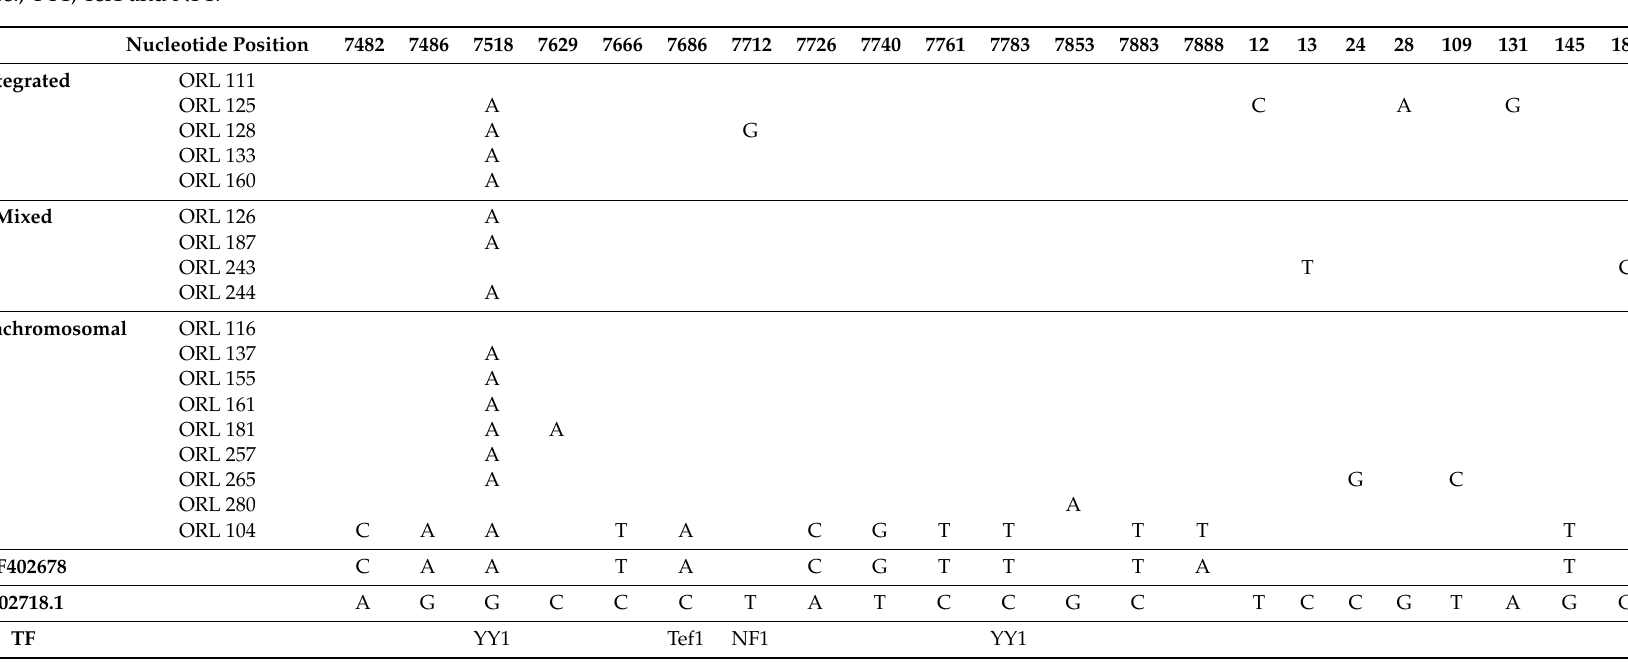
Table 3. Detection of nucleotide variation in the LCR region. Nucleotide positions of variations in samples as compared to HPV16 reference sequence